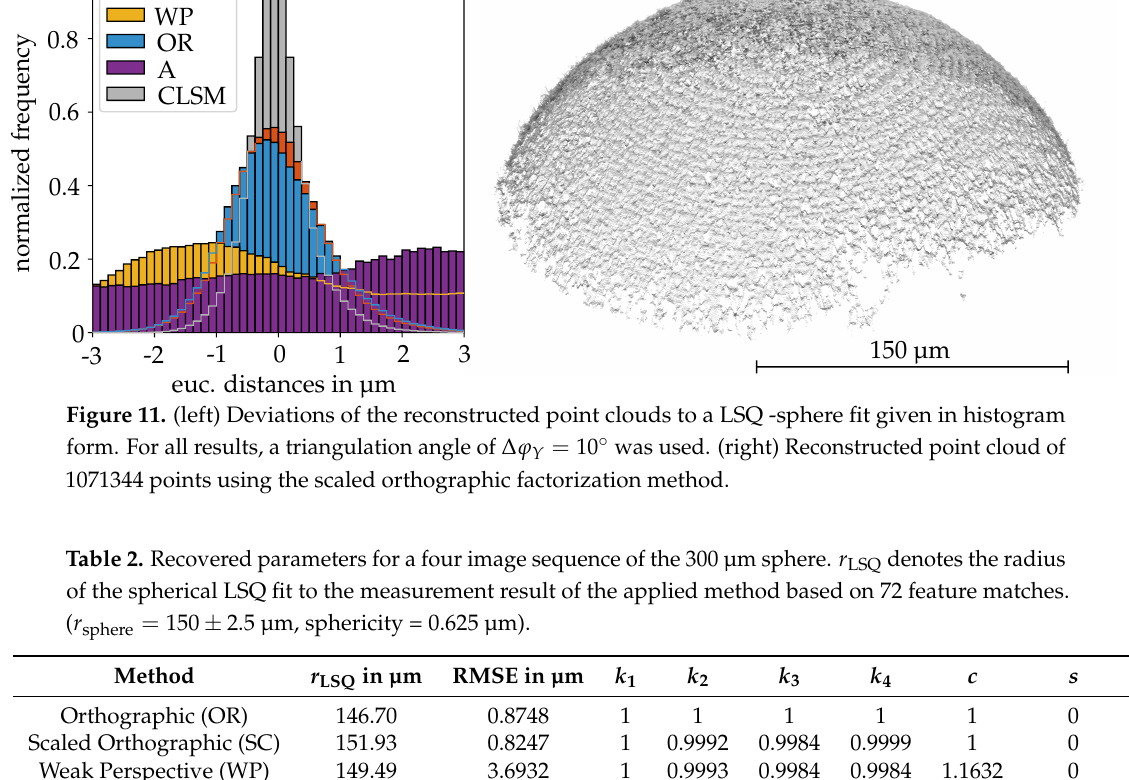
Weak Perspective ( c = 1 ) Affine ( c = 1, s = 0 )